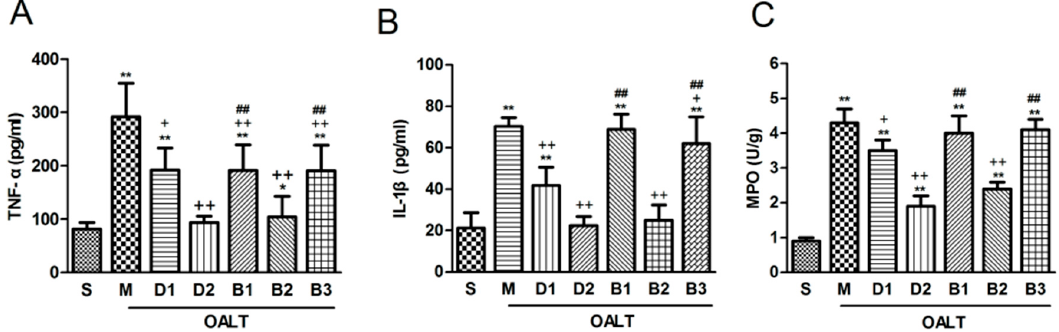
Figure 7. The concentrations of plasma TNF- α ( A ), IL-1 β ( B ) and activity of hepatic myeloperoxidase (MPO) ( C ) in the different groups. The data are expressed as the means ± SD ( n = 8). * p < 0.05, ** p < 0.01, vs. group S; + p < 0.05, ++ p < 0.01, vs. group M; ## p < 0.01, vs. group D2.